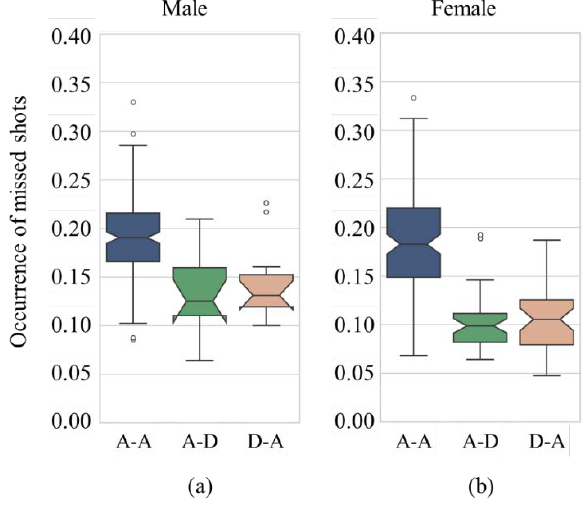
Figure 4 . Occurrence of missed shots for each combination of the server’s and receiver’s playing style: “A-A,” an offensive player served and an offensive player returned it; “A-D,” an offensive player served and a defensive player returned it; and “D-A,” a defensive player served and an offensive player returned it. The box and whiskers denote the maximum, minimum, median, first quartile and third quartile. The notches denote the 95% confidence intervals. The circle markers denote outliers, whose distance from the box is at least 1.5 times the inter quartile